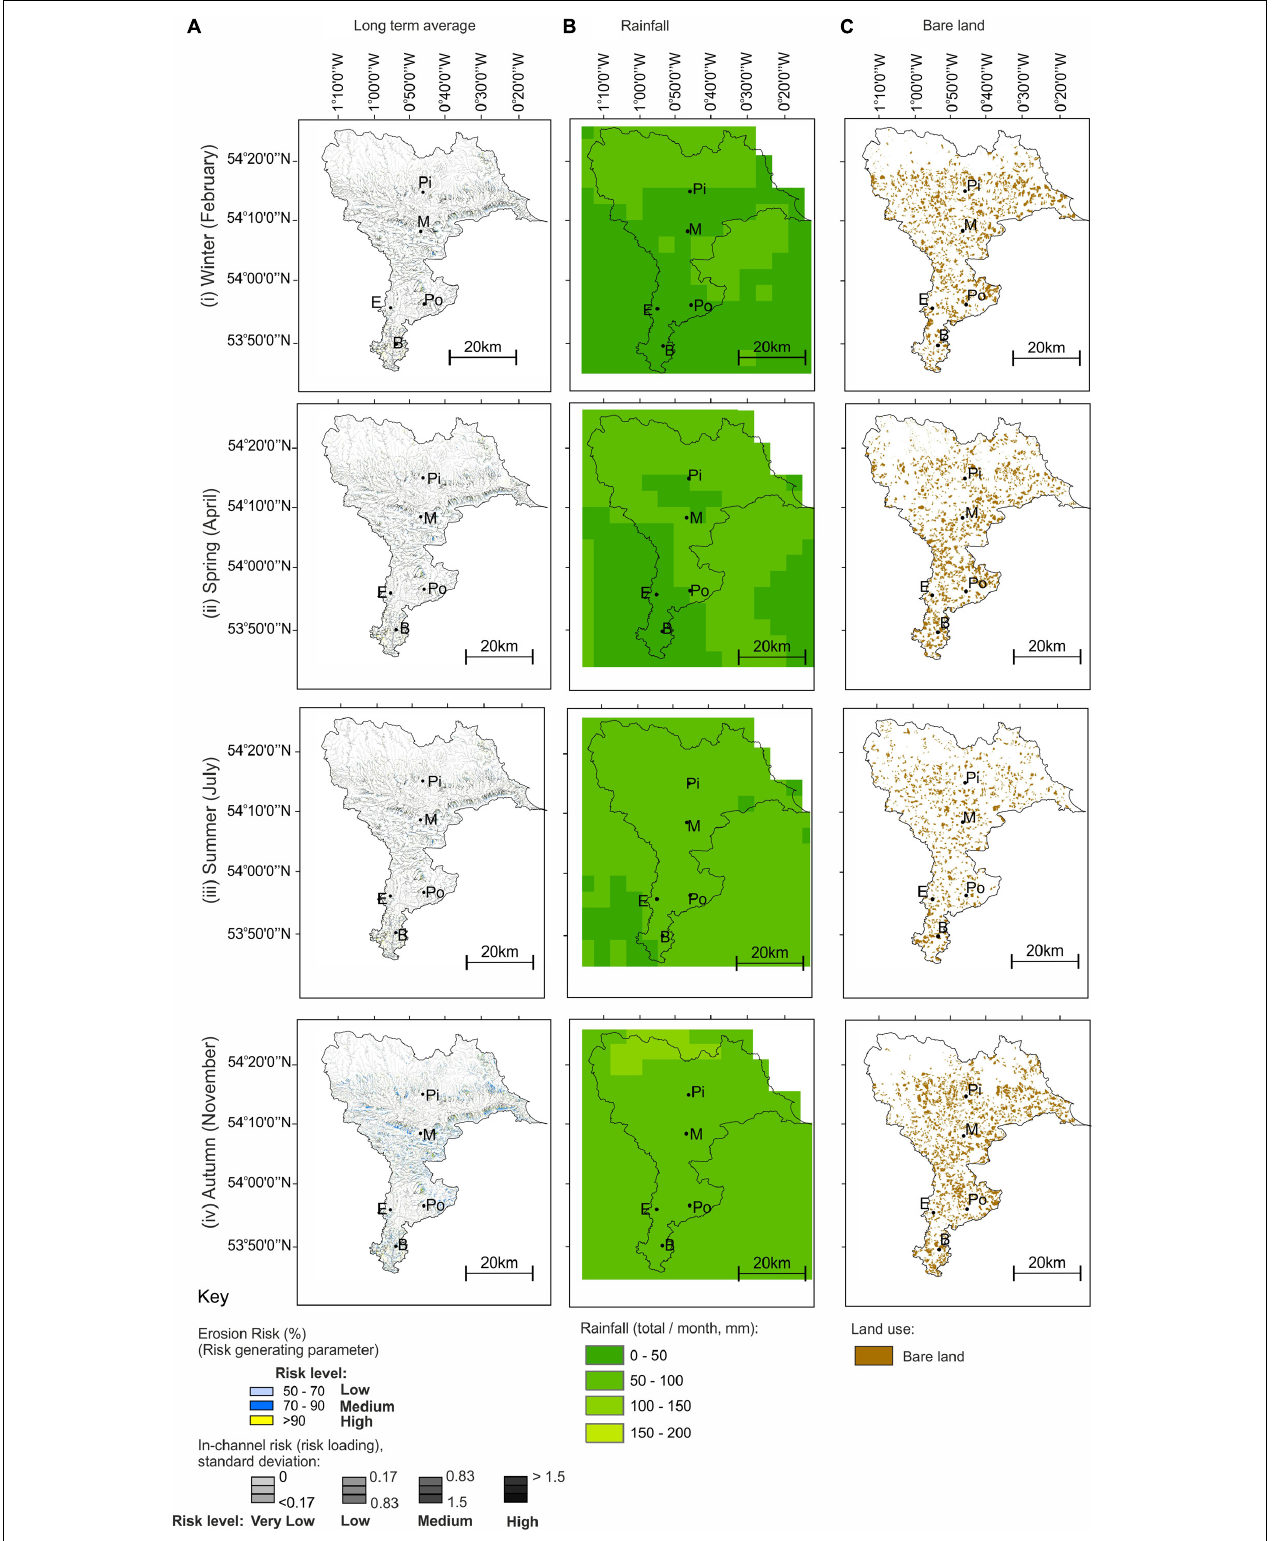
FIGURE 7 | Seasonal variation in (A) erosion risk; (B) rainfall data and (C) bare land for 2016, for (i) winter; (ii) Spring; (iii) Summer; and (iv) Autumn. Location are shown on each map; Pi, Pickering; M , Malton; Po, Pocklington; E, Elvington; and B, Bubwith.